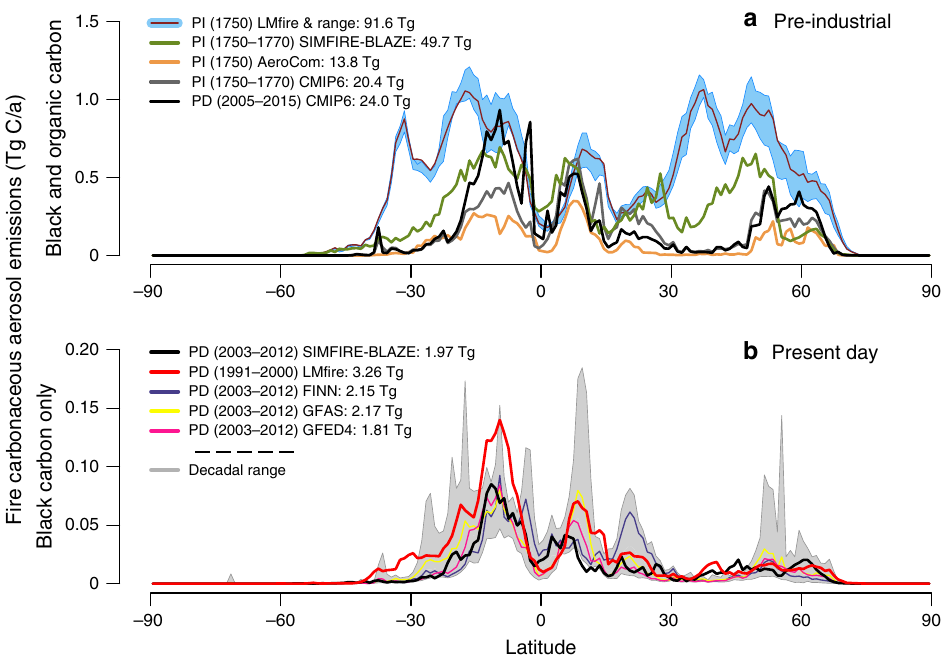
Fig. 1 Fire carbonaceous aerosol emissions. a Pre-industrial (PI) and present-day (PD) carbonaceous fi re emissions (sum of black and organic carbon) as a function of latitude. PI fi re emissions derived from four fi re datasets: LM fi re, SIMFIRE-BLAZE, CMIP6 and AeroCom. PD fi re emissions are from the CMIP6 dataset. The range around LM fi re represents a plausible range in the natural variability of PI fi re emissions derived from the maximum and minimum in fi re emissions from the four distinct decadal mean fi re climatologies. Seasonal PI carbonaceous aerosol emission maps are shown in Supplementary Figure 4. b Black carbon emissions for PD from fi ve datasets: LM fi re, SIMFIRE-BLAZE, GFED4, GFAS and FINN (mean of 2003 – 2012 for all except LM fi re which is the mean over 1991 – 2000). Shaded area represents the minimum and maximum in decadal emissions from within all three observation